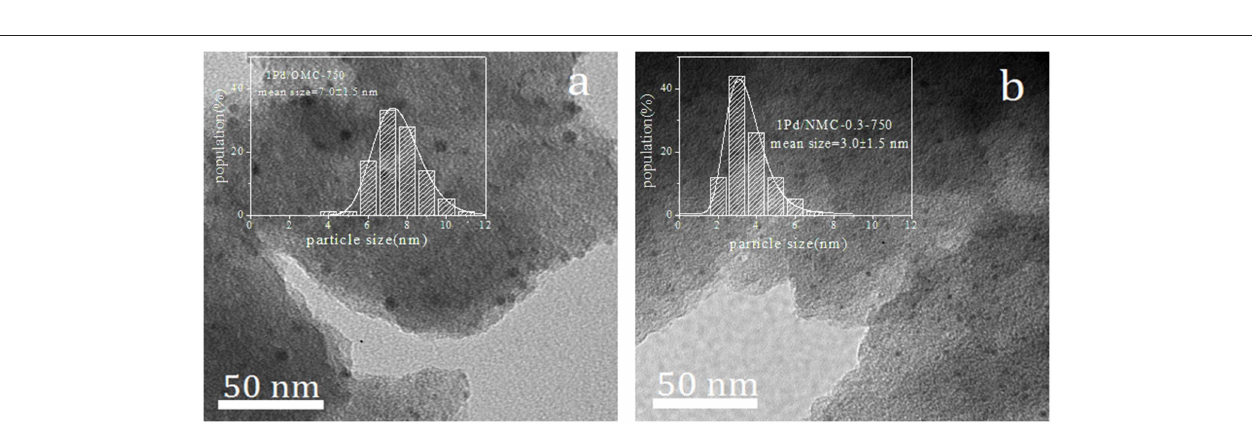
FIGURE 5 | TEM micrographs and its corresponding Pd particles size distributions of NOMC–supported catalysts: 1Pd/OMC − 750 (a) , 1Pd/NOMC − 0.3–750 (b) .